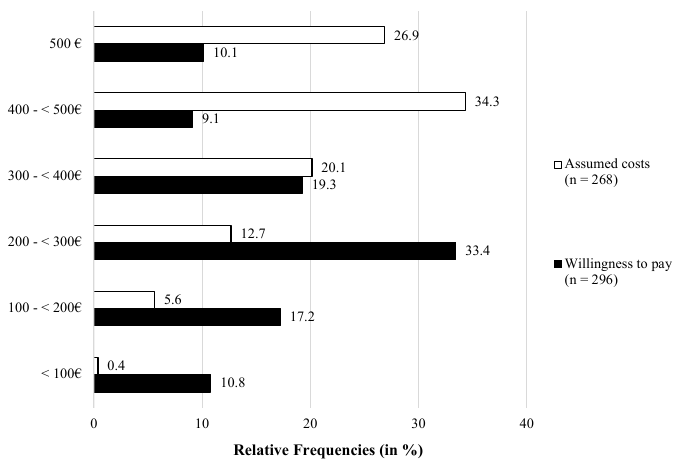
Figure 5. Assumed costs of and willingness to pay for sensor-based lifelogging technologies (RQ4 &